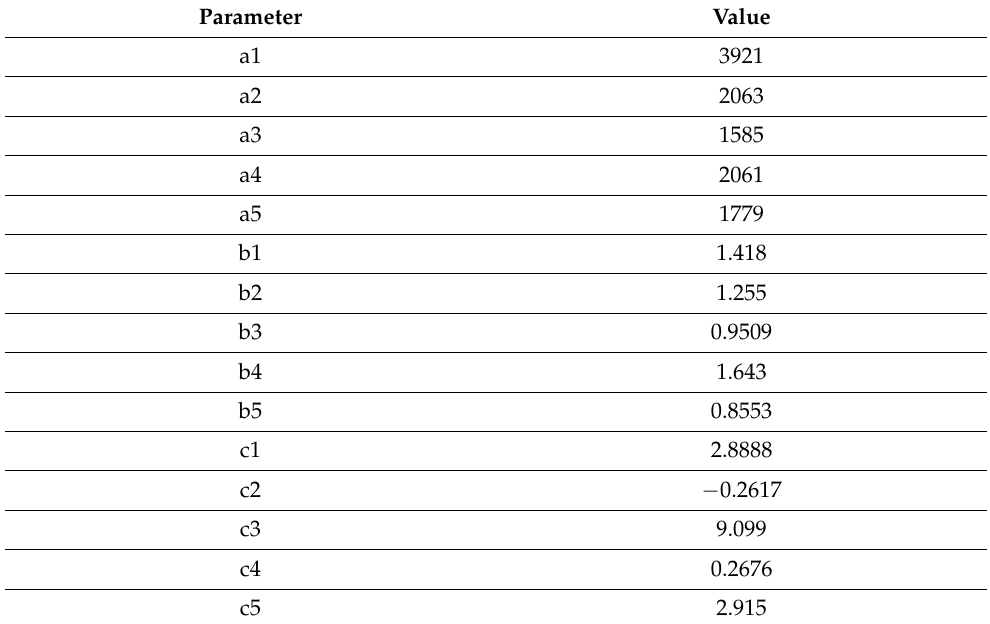
Figure 6. Drag and total force exerted on a VBT. Table 3. Values of curve fitting parameters related to Equation